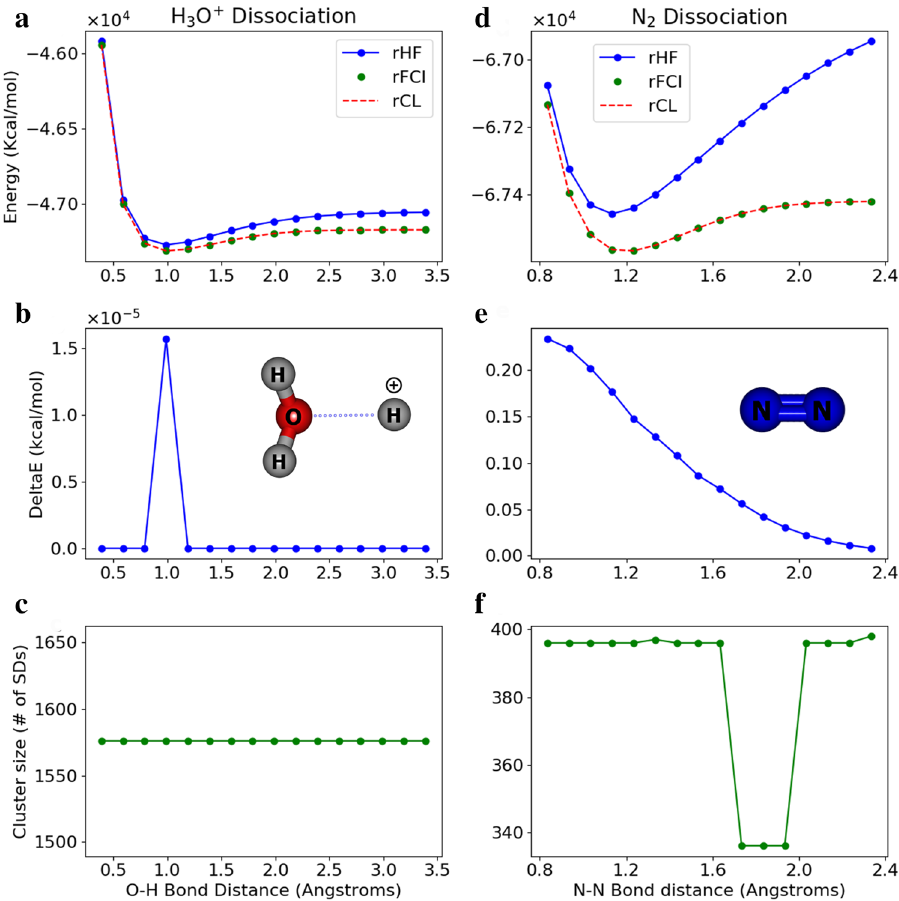
Figure 5. Bond dissociation for H 3 O + and N 2 . ( a ) Showing H 3 O + bond dissociation using the reduced sub- matrices discovered using Quantum Community Detection . The lowest energy bond distance is 0.99 Å. The FCI and cluster (CL) energies across all distances are nearly the same. ( b ) Most of the energy differences are within 10 − 10 kcal/mol across all O–H bond distances, though the lowest energy point is within 10 − 05 kcal/mol. ( c ) The reduced sub-matrix size for all bond distances is 1576 (from low energy clusters). This is a 50% reduction from the original matrices of size 3136 SDs. ( d ) Showing potential energy curve for N 2 bond dissociation. ( e ) N 2 energy differences decrease with larger bond distance. ( f ) Reduced sub-matrix sizes for N 2 vary from 363 to 397 SDs out of 1824 across available bond